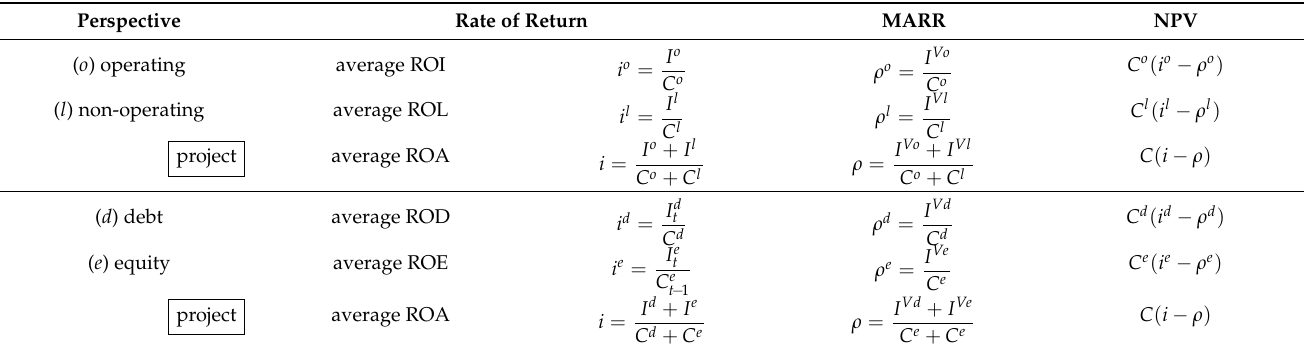
Table 4. Link among NPV, rate of return and benchmark rate of